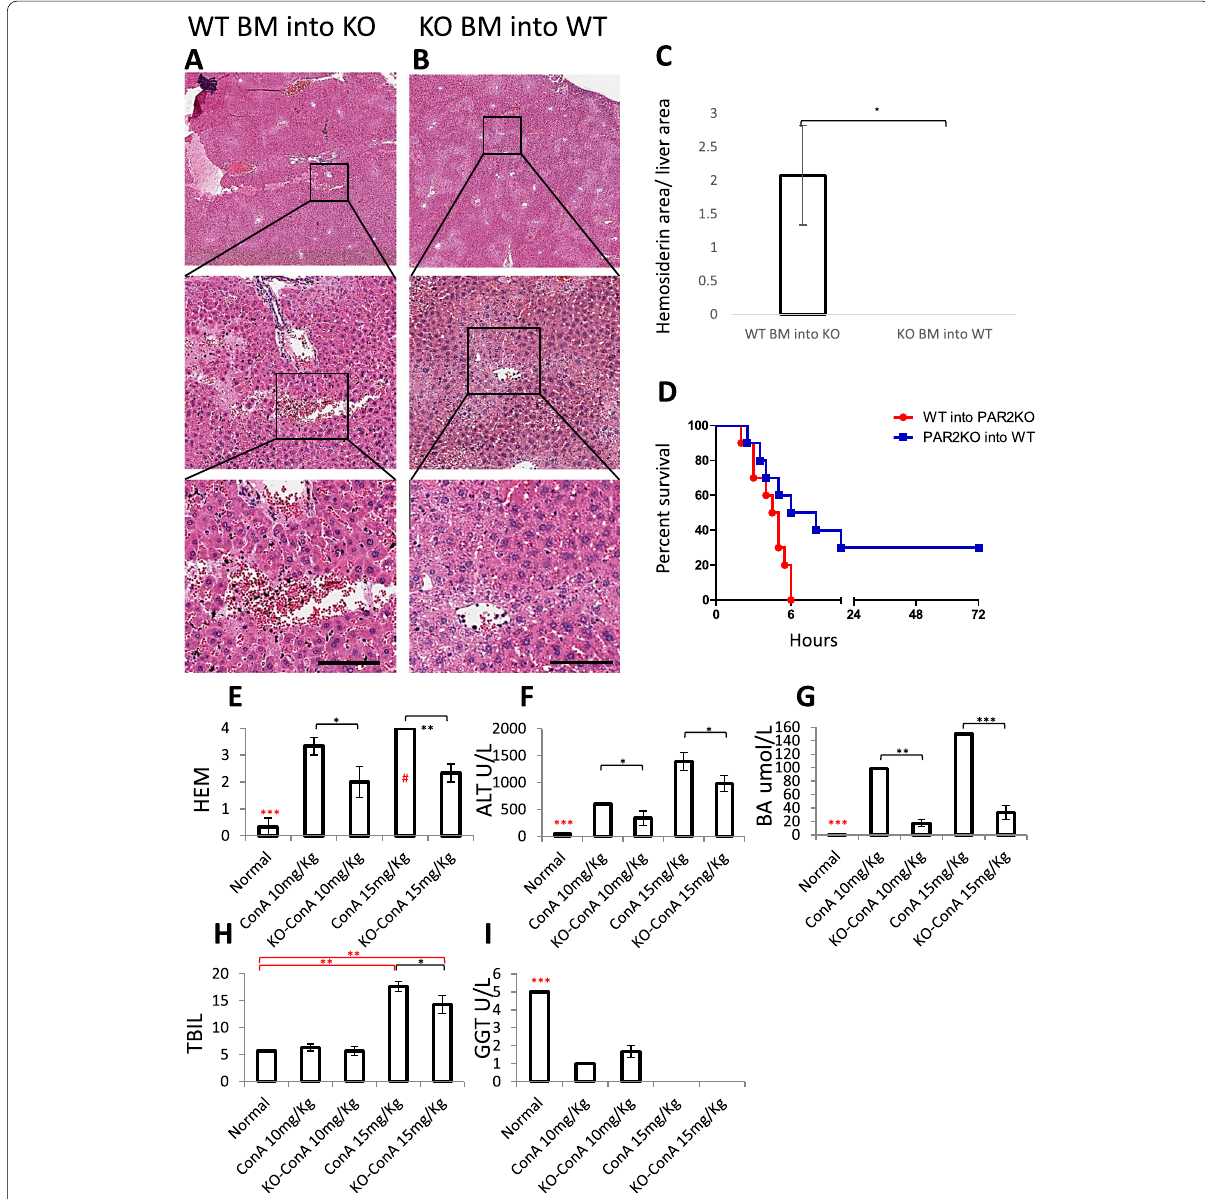
Fig. 5 BM replacement experiment with high-dose ConA treatment show that the ConA effect is mediated by Par2 activation. A WT BM-reconstituted Par2KO mice 6 h after high-dose ConA injection showing hemorrhage. B Par2KO BM-reconstituted WT mice 6 h after high-dose ConA injection—hemorrhage was practically absent. Scale bar 75μm. C Hemorrhage quantification (by hemosiderin area) shows that it appears = in WT BM-reconstituted Par2KO mice and not in the reciprocal experiment ( n 3 for each group). Statistical significance was measured using T test; = error bars SEM. D Kaplan-Meier survival plot of WT BM-reconstituted Par2KO mice (red, n 10) and Par2KO BM-reconstituted WT mice (blue, n 10) = = = after 15mg/kg ConA injection. Log-rank (Mantel-Cox) test for p value 0.0295. E – I Analysis of serum markers of liver damage 6 h after injection = of 10 or 15 mg/kg ConA, determined by VetScan VS2. E Hemolysis (HEM). Note that 4 is the assay limit (#). F Alanine aminotransferase (ALT). G Bile acid (BA). H Total bilirubin (TBIL). I Gamma glutamyl transferase (GGT), ( n 15, 3 for each group). Statistical significance was measured using T test. = *Indicates p <0.05, ** p <0.01, *** p <0.005, error bars SEM. Black—between groups as indicated. Red—untreated WT control in comparison to all = other groups or as